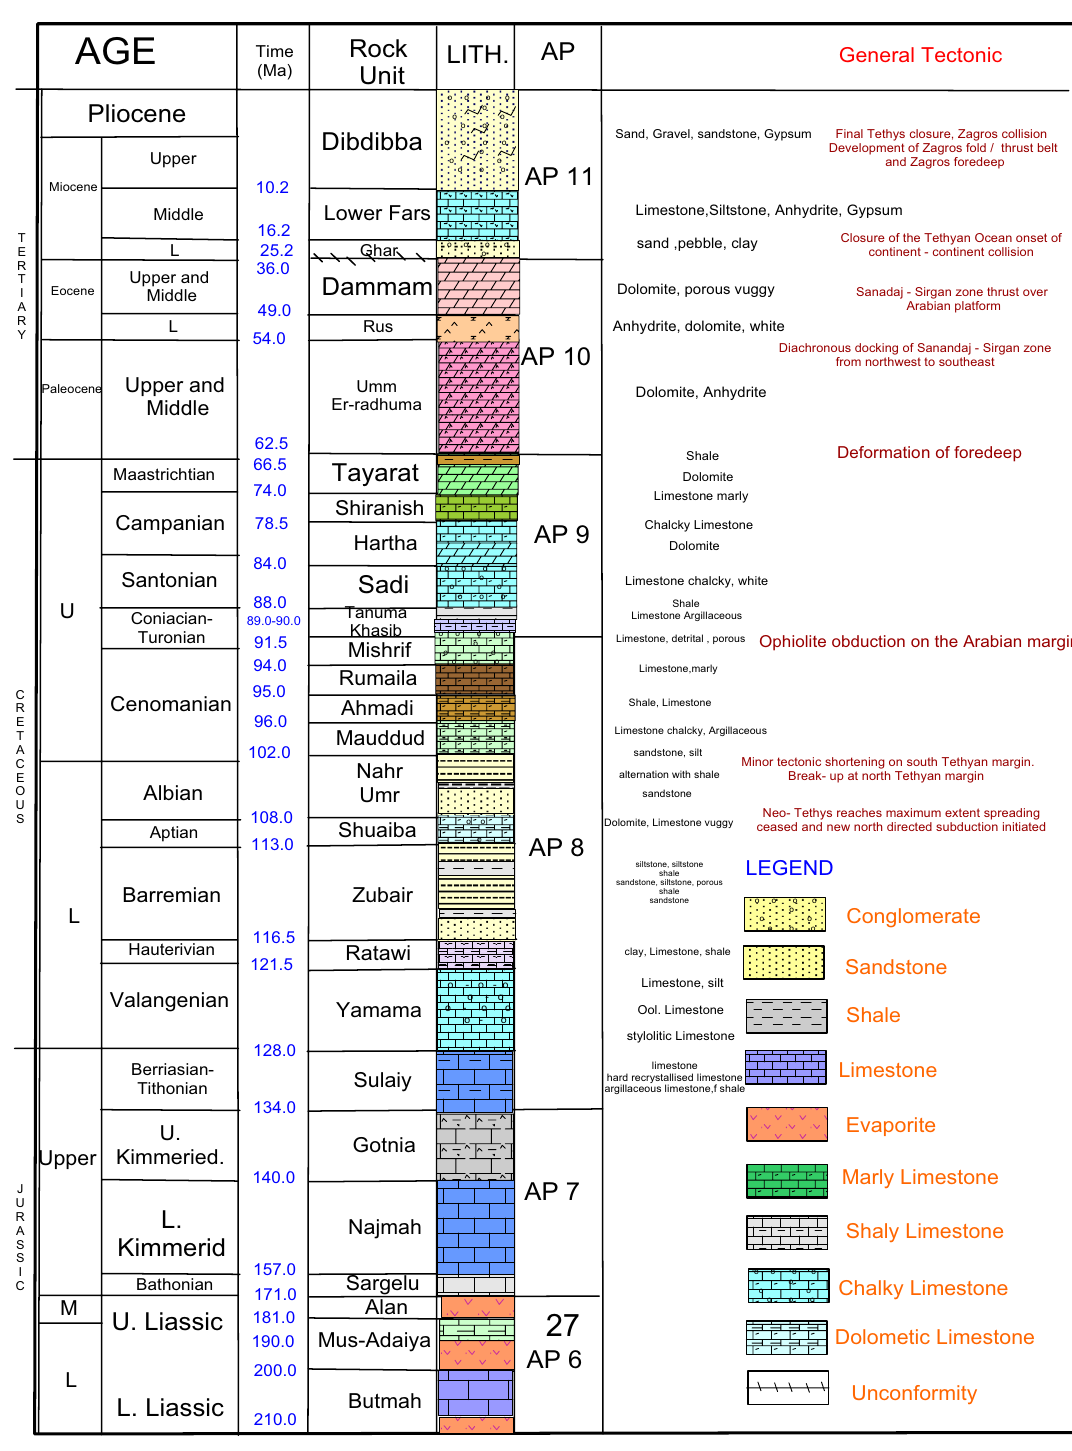
Figure 1. The generalized stratigraphic columnar section observed in the study area (generalized by using Didger 3 During the Berriasian–Valanginian period, with the conclusion of the Neo-Tethys Sea Formation, tectonic events at the end of the Jurassic period led to the construction of the Tikrit High, with the architecture extending from northwest to southeast. Due to erosion, a shallow basin grew deeper towards Amara, Halfaya, and Bazerkan, preparing it for the calcareous sediments of the Yamama basin. "Transform faults" are faults that run north–south and crosswise in the direction of the Zagros, as seen by the continued sedimentation of the basin’s Chia Gara Formation as the lower part. To the east is the Karimia Formation, a clay limestone with Berriasian rocks in its upper portions. In southern Iraq, the Sulaiy and Yamama